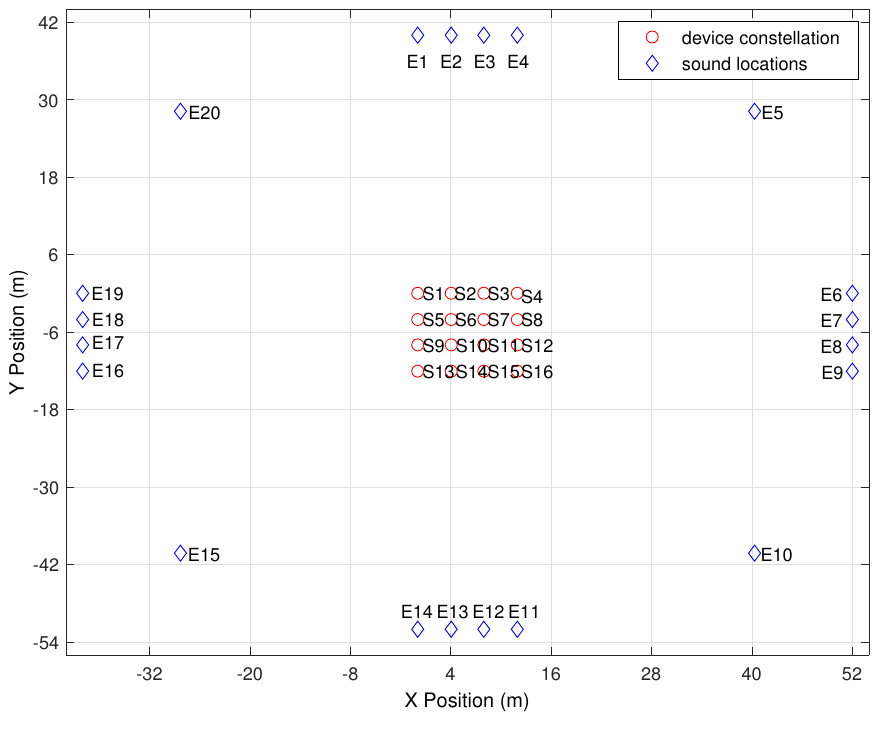
Figure 9. Experimental outdoor